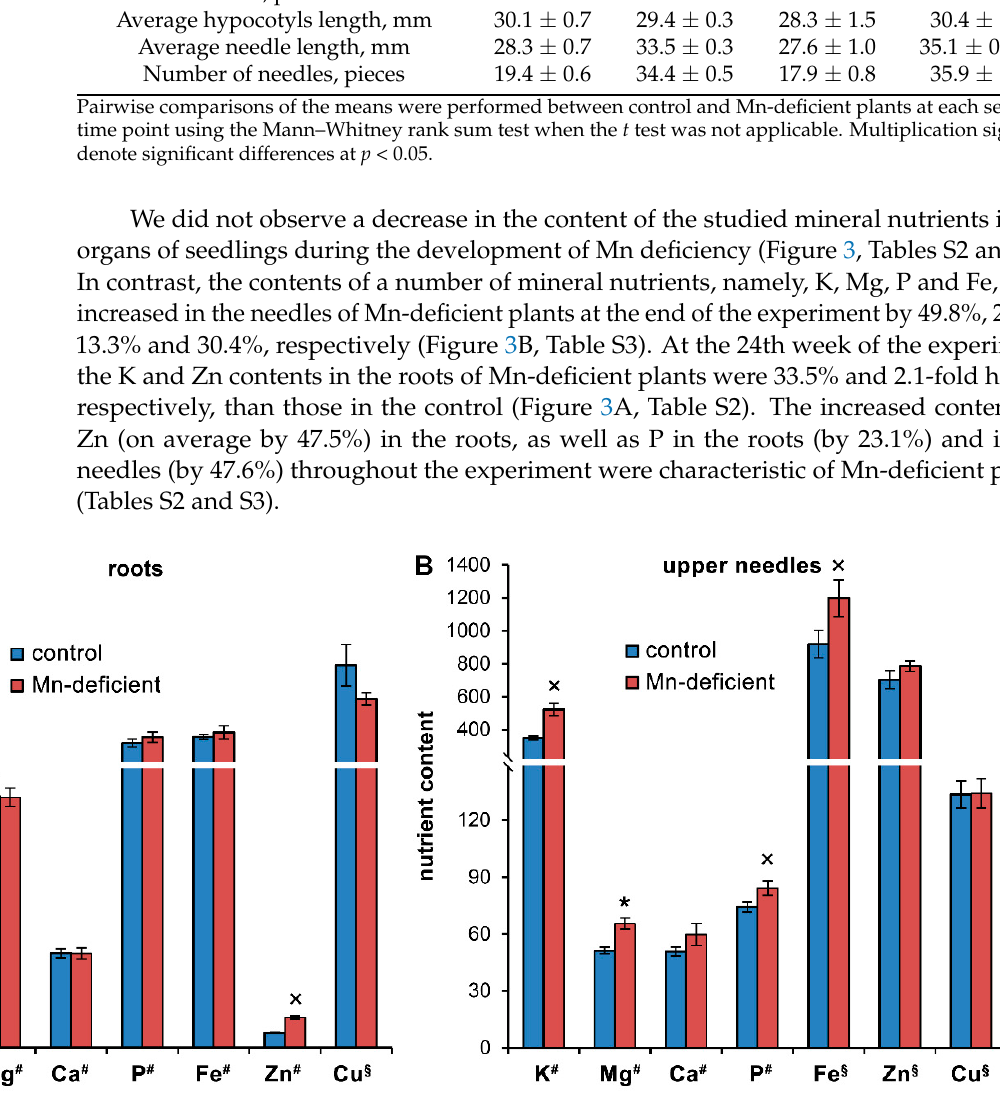
Table 2. Growth parameters of Scots pine seedlings at the 4th and 6th weeks of the experiment.